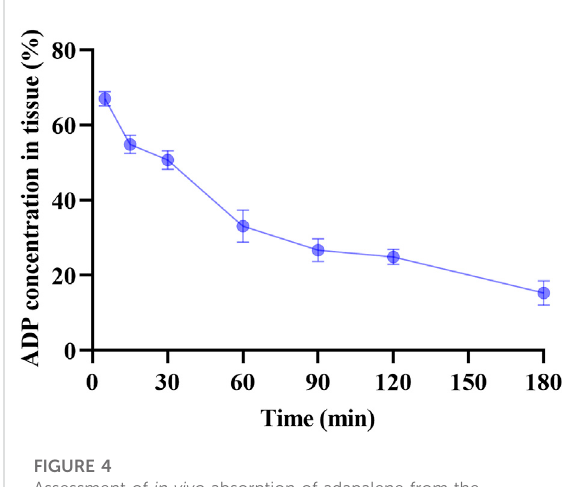
FIGURE 4 Assessment of in vivo absorption of adapalene from the developed mucoadhesive gel. The numeric values on the y -axis represent the average percentage of adapalene recovered from the cervical tissue of mice plotted against time ( n =